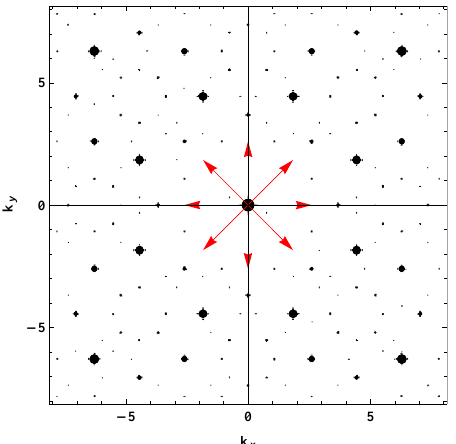
Figure 5. The structure factor calculated using Equation (11) for a sample of 4000 sites of the optical quasicrystal ( p = 0). Intensities of the peaks are proportional to the area of the spots, and k x and k y are given in units of λ − 1 . Arrows indicate the eight shortest reciprocal lattice